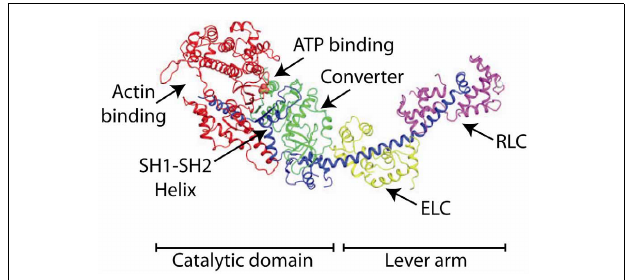
FIGURE 6 | The crystal structure of chicken skeletal muscle S1. The heavy chain is colored (from N-terminal to C-terminal sequence) in green, red, and blue. The ELC is colored lime and the RLC is colored magenta. The positions of various domains are